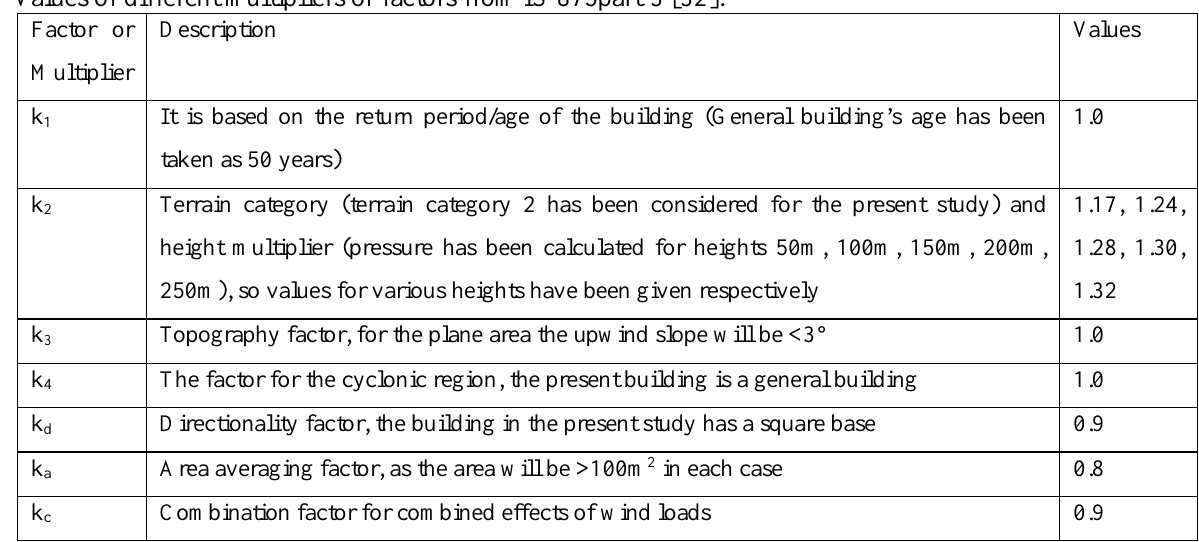
Values of different multipliers or factors from IS-875part-3